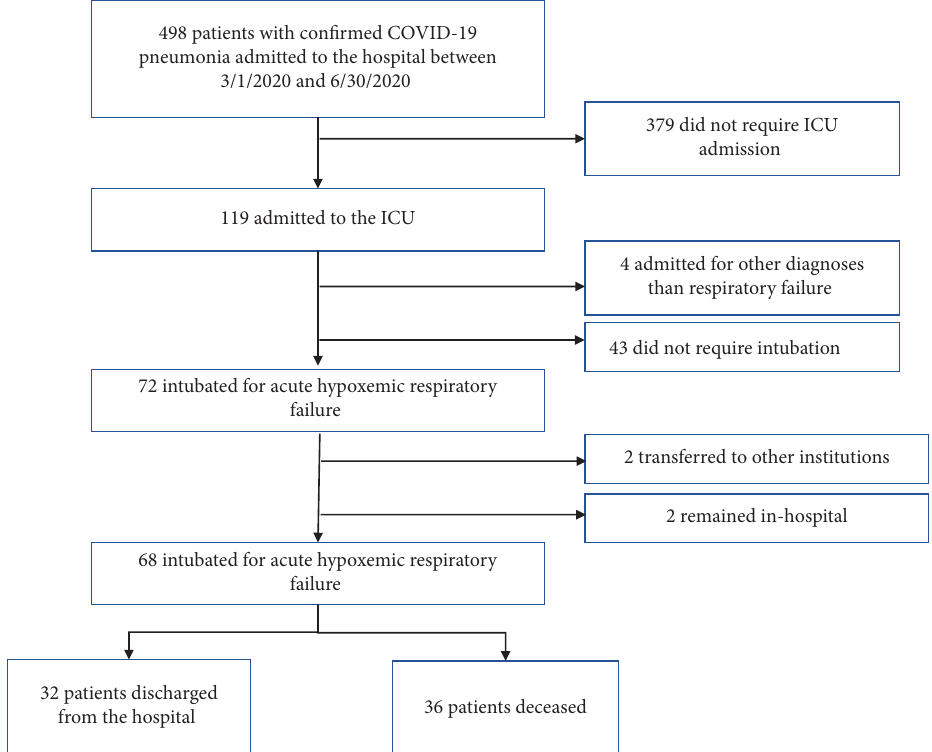
Figure 1: Flow diagram for inclusion of COVID-19 patients in the final